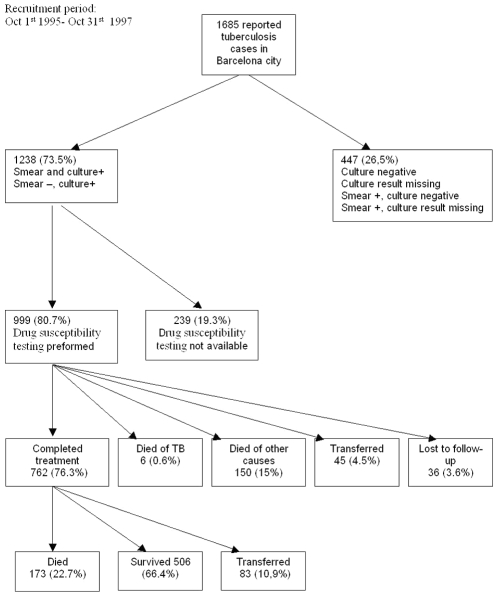
Flow chart of tuberculosis patient selection and evolution.Barcelona, 1995–2005.